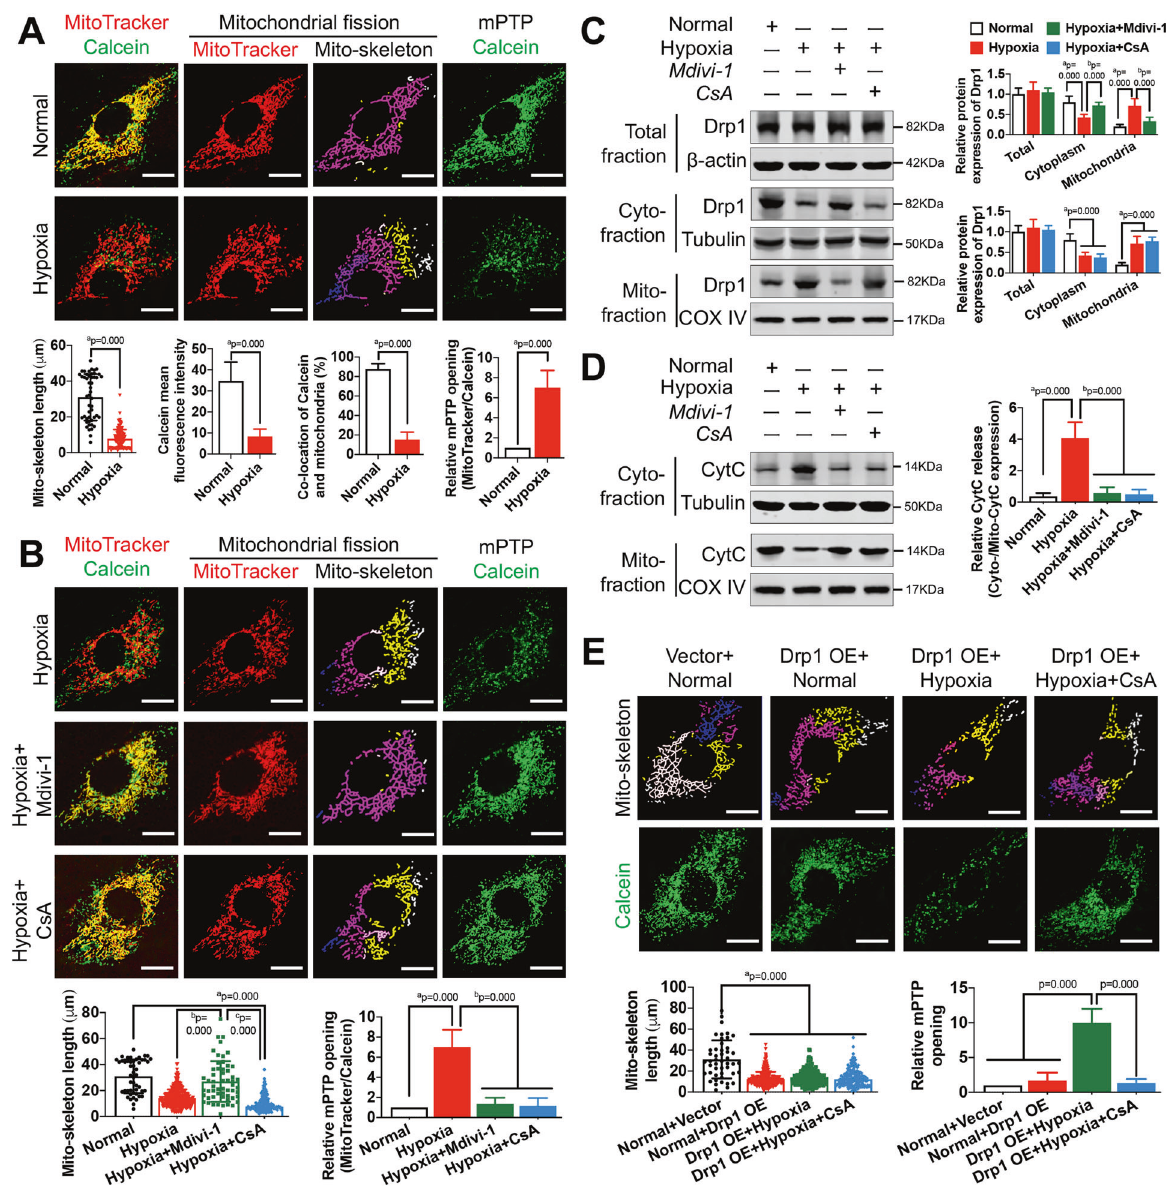
Fig. 1 The effects of mitochondrial Drp1 on mPTP opening after hypoxia. A Representative confocal images of mPTP opening in VSMCs after hypoxia (bar, 25 μ m). VSMCs were labeled with Calcein and MitoTracker to re fl ect mPTP opening and mitochondrial skeleton. B Representative confocal images of mPTP opening in hypoxia-induced VSMCs after Mdivi-1 (50 μ M) or CsA (10 μ M) treatment. Mitochondrial length and relative mPTP opening ratio in each group were calculated by Image J. C Relative protein expression of Drp1 in total, cytoplasmic and mitochondrial fractions of hypoxia-induced VSMCs after Mdivi-1 (50 μ M) or CsA (10 μ M) treatment. β -actin, Tubulin and COX IV were used as interior references of total, cytoplasmic and mitochondrial fractions. ( n = 8 samples/group). D Relative protein expression of CytC in cytoplasmic and mitochondrial fractions of hypoxia-induced VSMCs after Mdivi-1 (50 μ M) or CsA (10 μ M) treatment. ( n = 8 samples/group). E Representative confocal images of mPTP opening in Drp1-over expressed (Drp1 OE) VSMCs after hypoxia and CsA (10 μ M) treatment. Mitochondrial length and relative mPTP opening ratio in each group were calculated by Image J. a: P < 0.05 compared with Normal group, b: P < 0.05 compared with Hypoxia group, c: P < 0.05 compared with Hypoxia + Mdivi-1